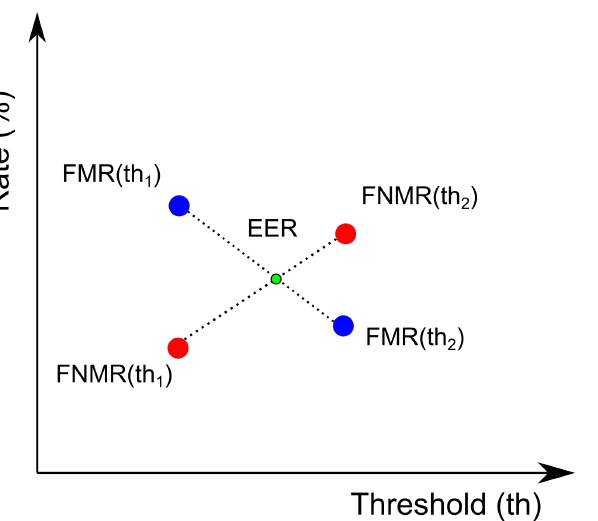
Figure 6. Graphic representation of the EER calculation from FNMR and FMR data.